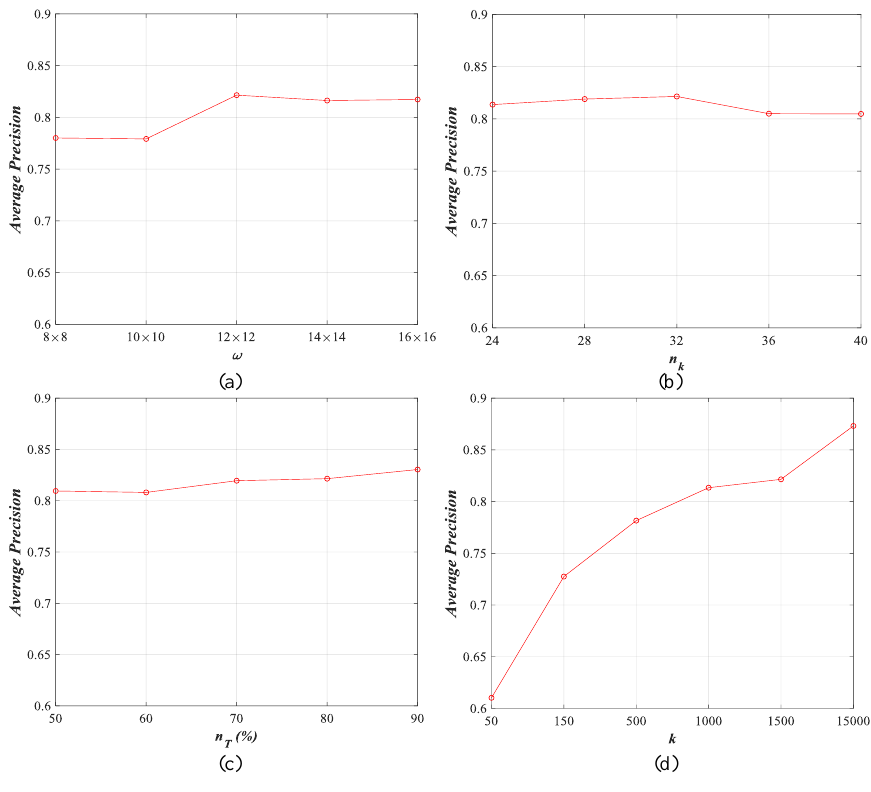
Figure 26. Influence of different parameters for ImgDB4. ( a ) ω ; ( b ) n k ; ( c ) n T ; ( d ) k